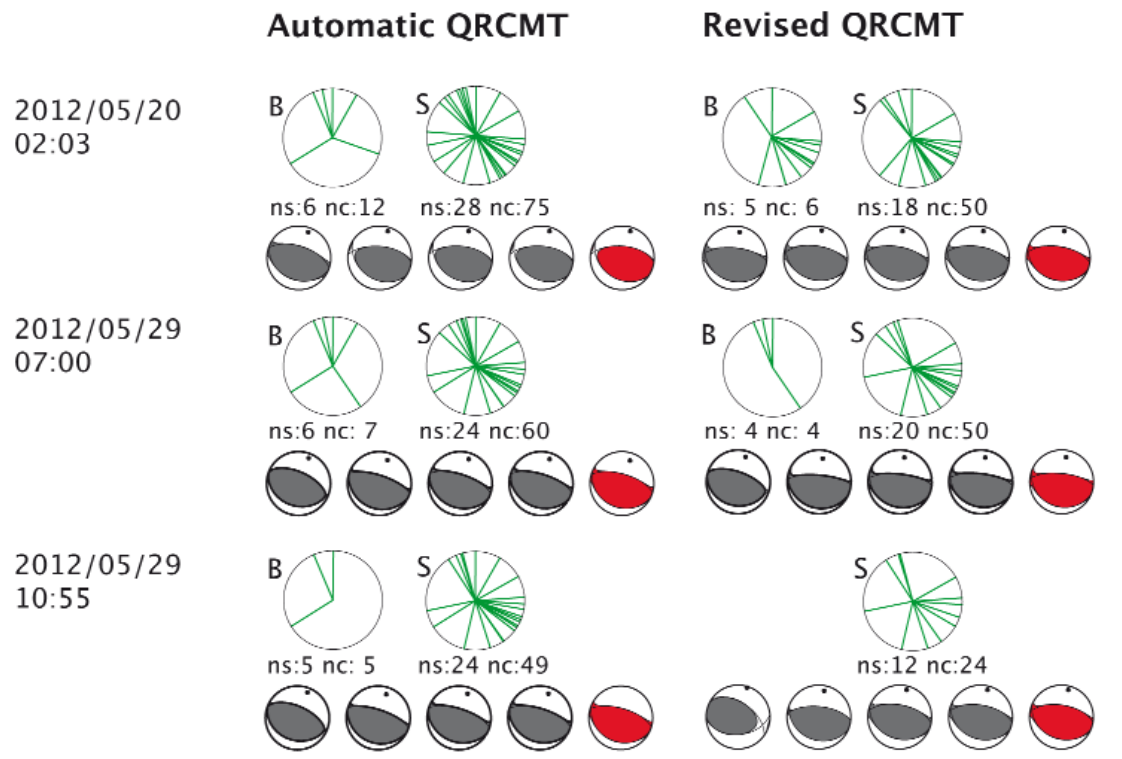
Figure 4. Comparison between the automatic and revised conditions for the three events of the seismic sequence with M >5.5. Upper parts: For each QRCMT, the station distribution is shown around the epicenter for surface (S) and body (B) waves, and the number of stations (ns) and number of components (nc) used in the inversion. Lower parts: All five moment tensors are shown, as obtained for each iteration of the inversion, where the red one is the final